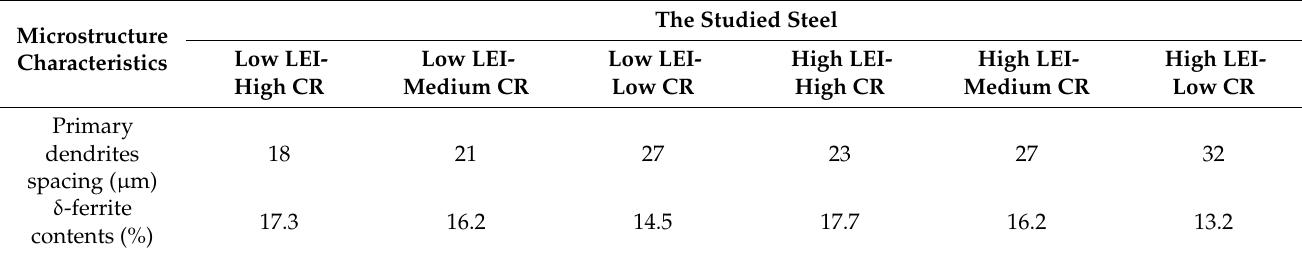
Table 3. δ -ferrite contents and primary dendrites spacing of the AM parts under different LEIs and CRs. Microstructure